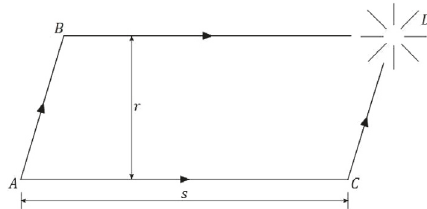
Figure 2: Experiment to detect gravity-induced quantum interfer-